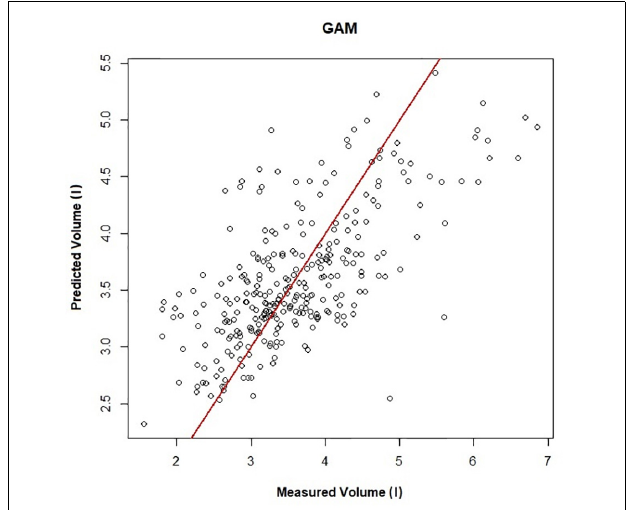
FIGURE 2 | Predicted vs. measured inspired tidal volume ( r 2 = 0.45). The GAMs model is used to generate the predicted volume, and measured volume is the inspired tidal volume measured using the pneumotachometer, red line is the line of unity.